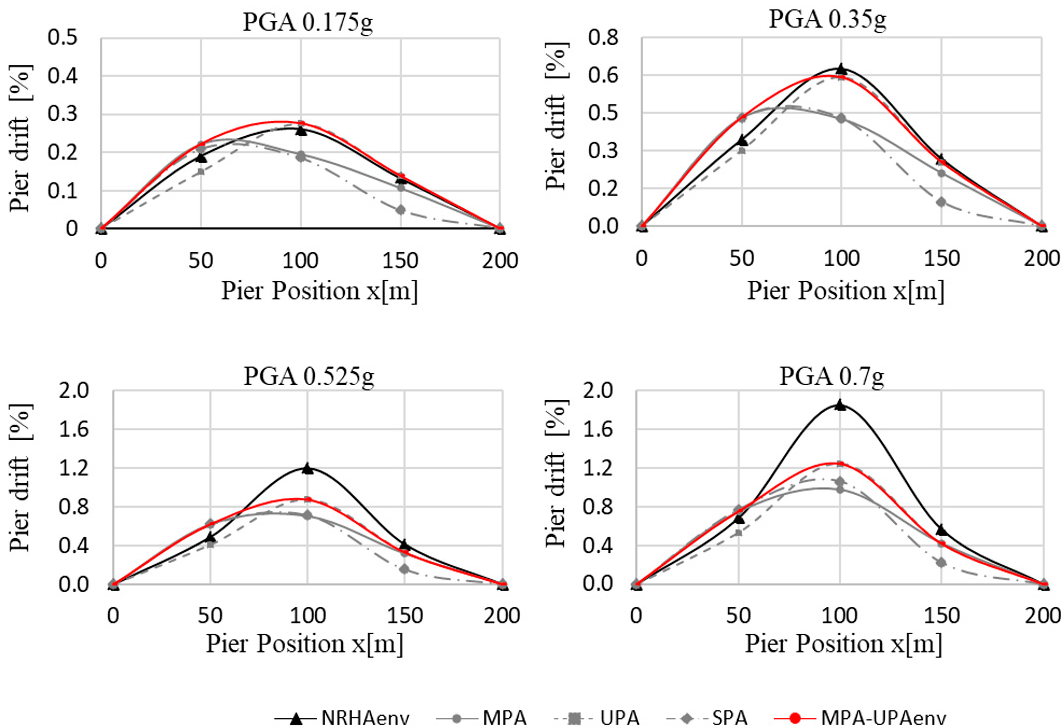
Figure 21. Irregular bridge—pier drift (transversal top displacement/height) derived by performing nonlinear dynamic analysis and pushover analysis according to the approaches considered (PGA from 0.175 to 0.7 g).